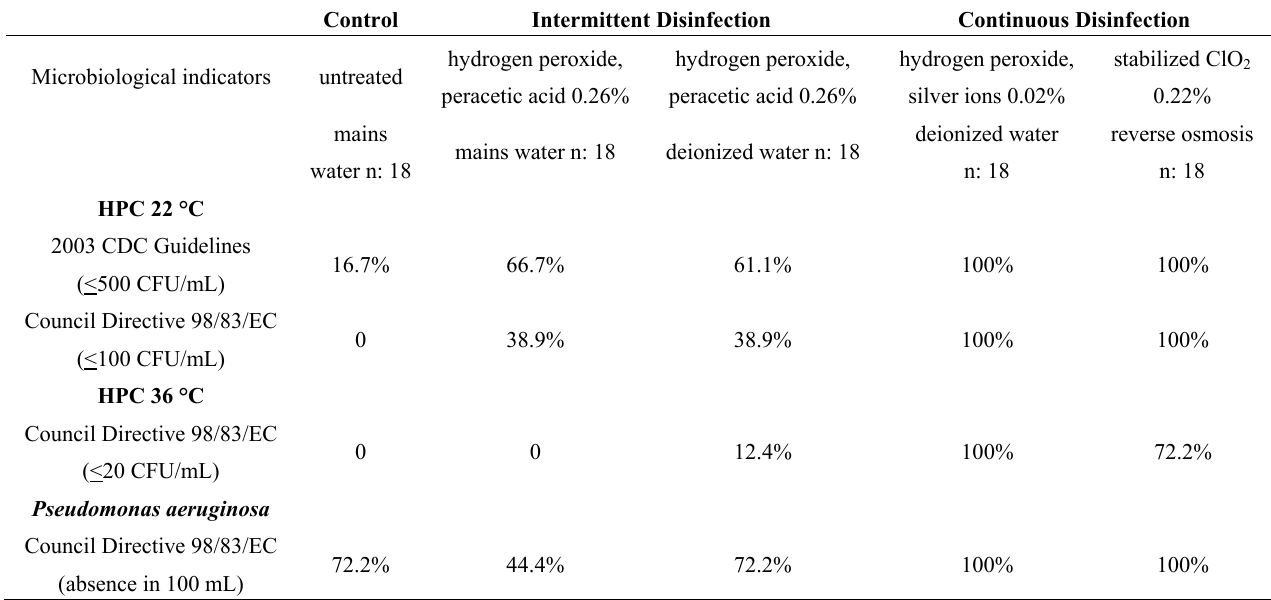
Table 2. Compliance of samples to water